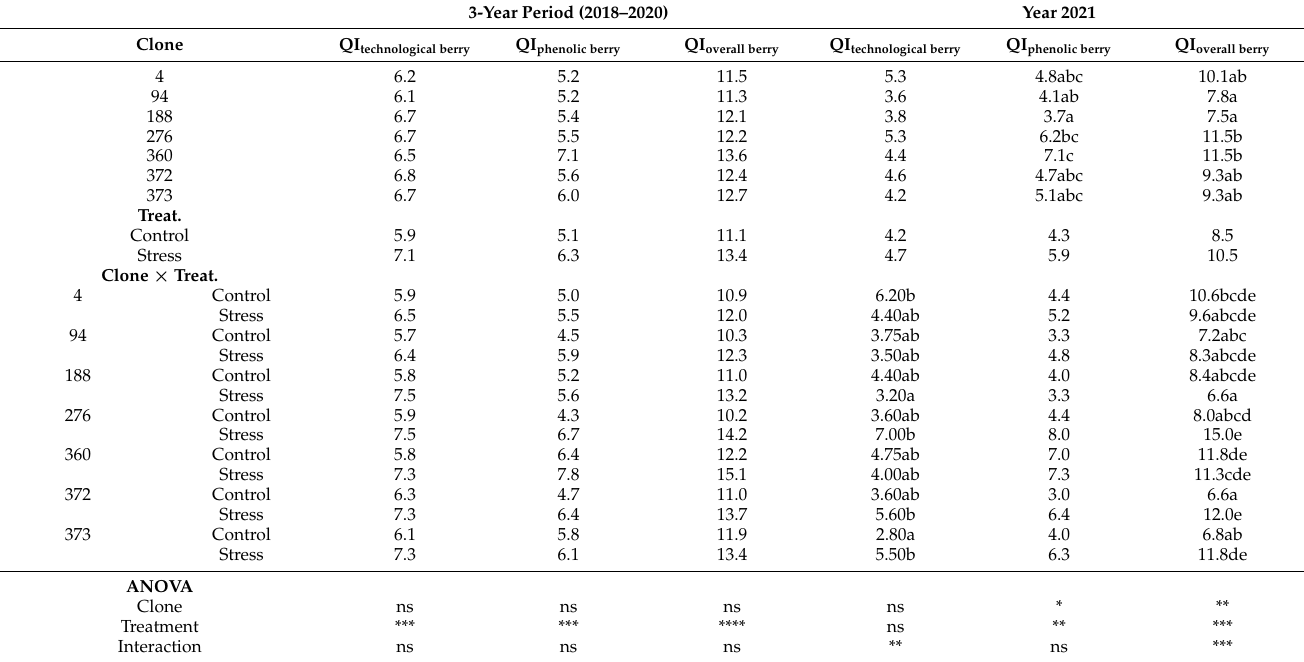
Table 8. Average annual values of berry technological quality index (QI technological berry), berry phenolic quality index (QI phenolic berry), and overall berry quality index (QI overall berry) cal- culated for Monastrell grapes at harvest for each clone, irrigation treatment, and the interaction (clones × irrigation treatment) during the 3-year period 2018–2020 and in year